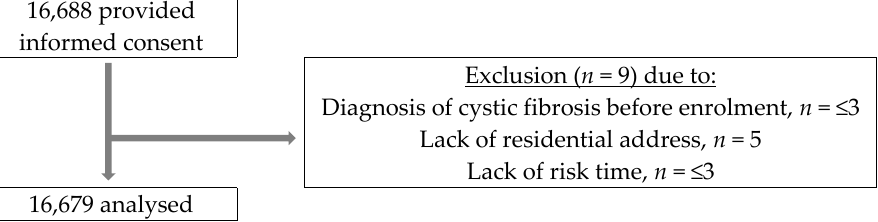
Figure 1. Flow diagram of cohort selection from the Danish Health and Morbidity Survey 2000. A total of 15,521 individuals did not have a diagnosis of asthma or COPD at baseline, 1158 individuals had either asthma or COPD at baseline, and 1157 individuals were